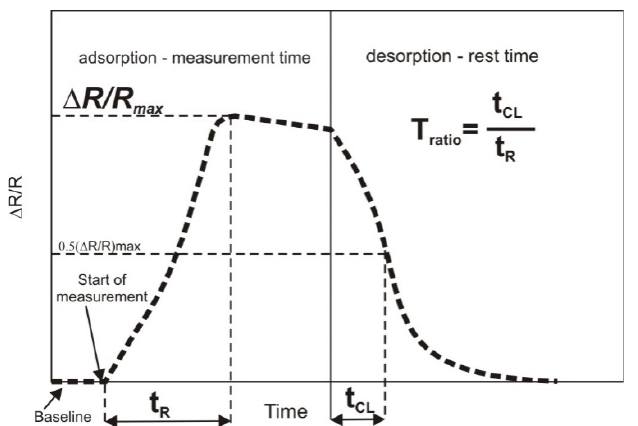
Figure 1. Scheme of a typical sensorgram for metal oxide semiconductor (MOS) sensors with a ratio of reaction times of T R and T CL marked on the graph (18) .